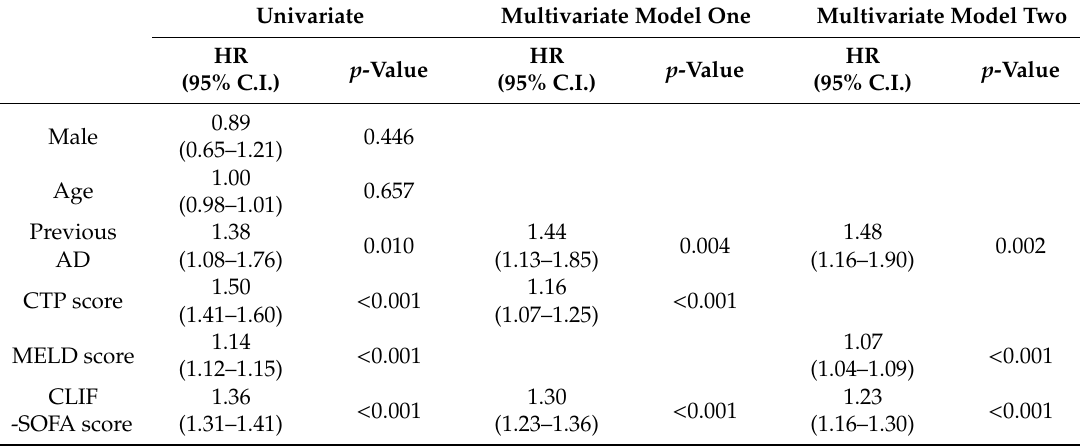
Table 2. Significant predictive factors for long-term mortality (including transplantation) in acutely deteriorated alcoholic LC patients.